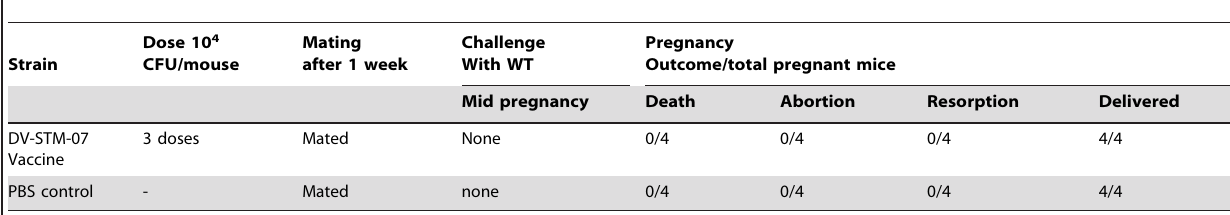
Table 4. Pregnancy outcome in pre-pregnancy vaccinated mice without WT challenge.